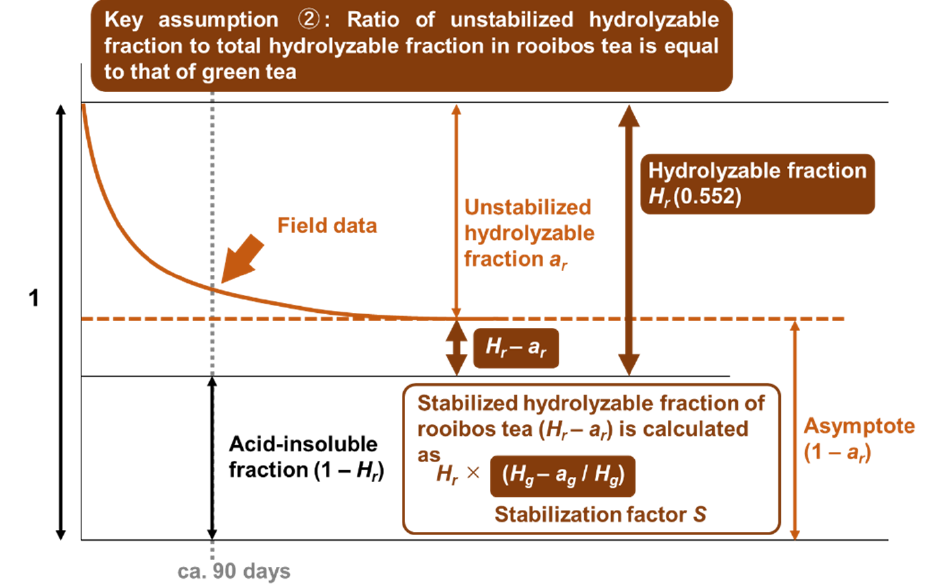
Figure 2. The second key assumption of the Tea Bag Index (TBI) approach and how to determine the decomposition constant k . It is assumed that the stabilization factor S (i.e., the ratio of the unstabilized hydrolyzable fraction to the total hydrolyzable fraction) of rooibos tea equals that of green tea. The figure is modified from Mori et al. [13].